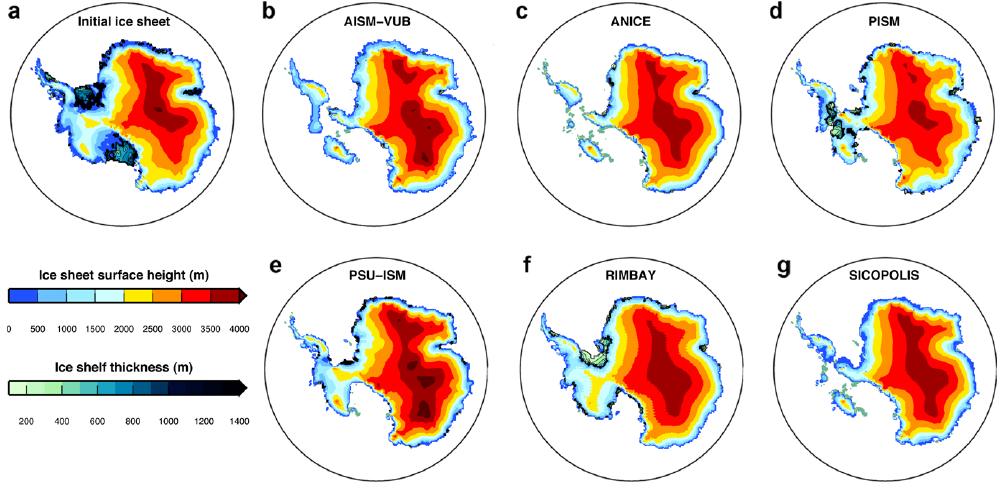
Figure 5. Ice surface topography and thickness of the ice shelves for the Pliocene Ice-PD simulation, with HadCM3 Pliocene climate forcing.